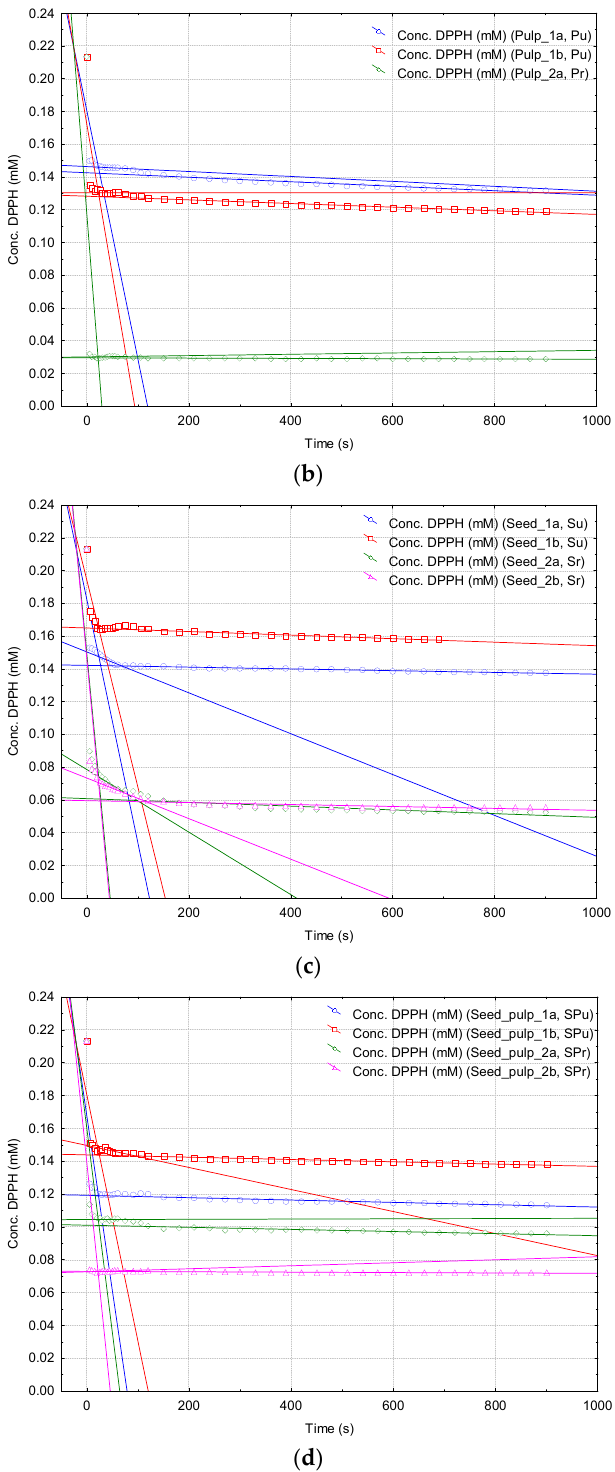
Figure 3. Concentration (DPPH·, mM) versus Time (s) plots for the reaction of DPPH· with antioxidant compounds from unripe and ripe papaya peel extracts (codes Lu and Lr ) ( a ), from the unripe and ripe papaya pulp extracts (codes Pu and Pr ) ( b ), from the unripe and ripe papaya seeds extracts (codes Su and Sr ) ( c ) and from the unripe and ripe papaya seed-pulp extracts (codes SPu and SPr ) ( d ). Determinations were performed as duplicates (excepting Lu and Pr samples). See Supplementary Material File for all